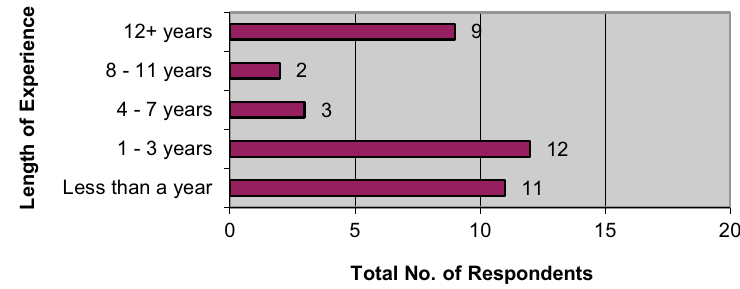
Figure 2. Reported years of experience with wildlife reintroductions among survey respondents. one year. Both action and monitoring phases most commonly took more than four years (Figure 3).